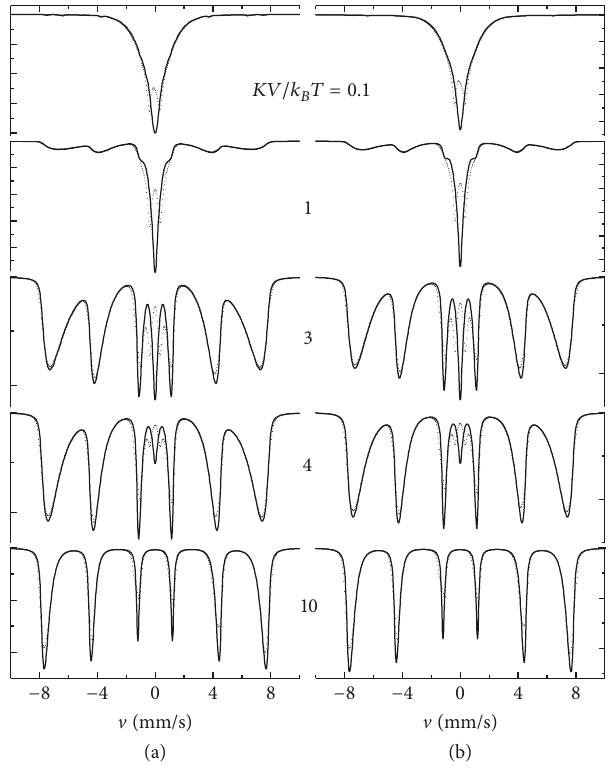
Figure 5: M¨ossbauer absorption spectra of 57 Fe nuclei in the ensembleofslowlyrelaxingideal( 𝛽 = 1 )antiferromagneticparticles (a) and the N´eel ensemble of slowly relaxing “uncompensated” ( 𝛽 = 1 , 𝜎 𝛽 = 0.03) antiferromagnetic particles (b) calculated within the model of magnetic dynamics (see main text) for different values of the effective energy barrier 𝐾𝑉/𝑘 𝐵 𝑇 in the presence (dotted lines) of the quadrupolar interaction with the constant 𝑞 = 0.35 mm/s and in the absence (solid lines) of this interaction ( 𝑞 = 0 ). Hereinafter, 𝐻 = 500 hf